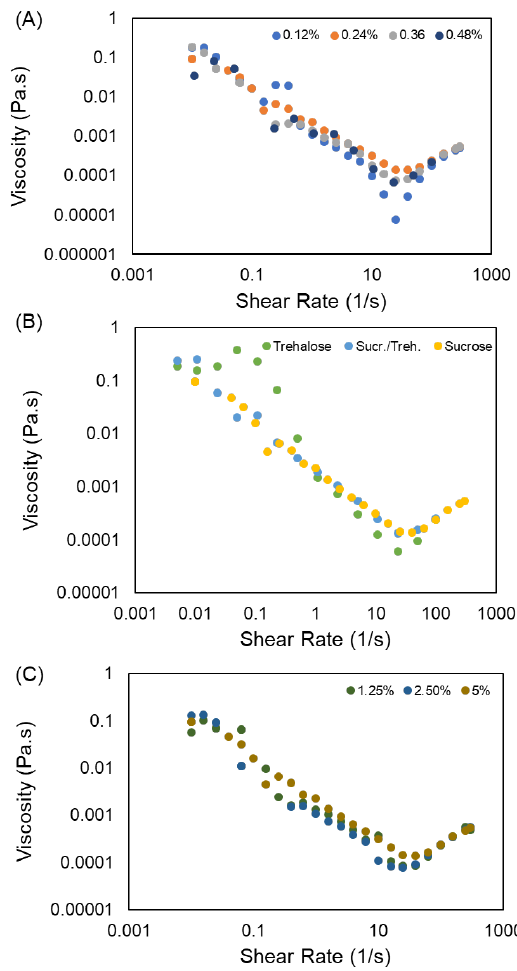
Figure 3. Effect of ( A ) chitosan concentration, ( B ) type of lyoprotectant, and ( C ) concentration of lyoprotectant on flow curves of the inks.